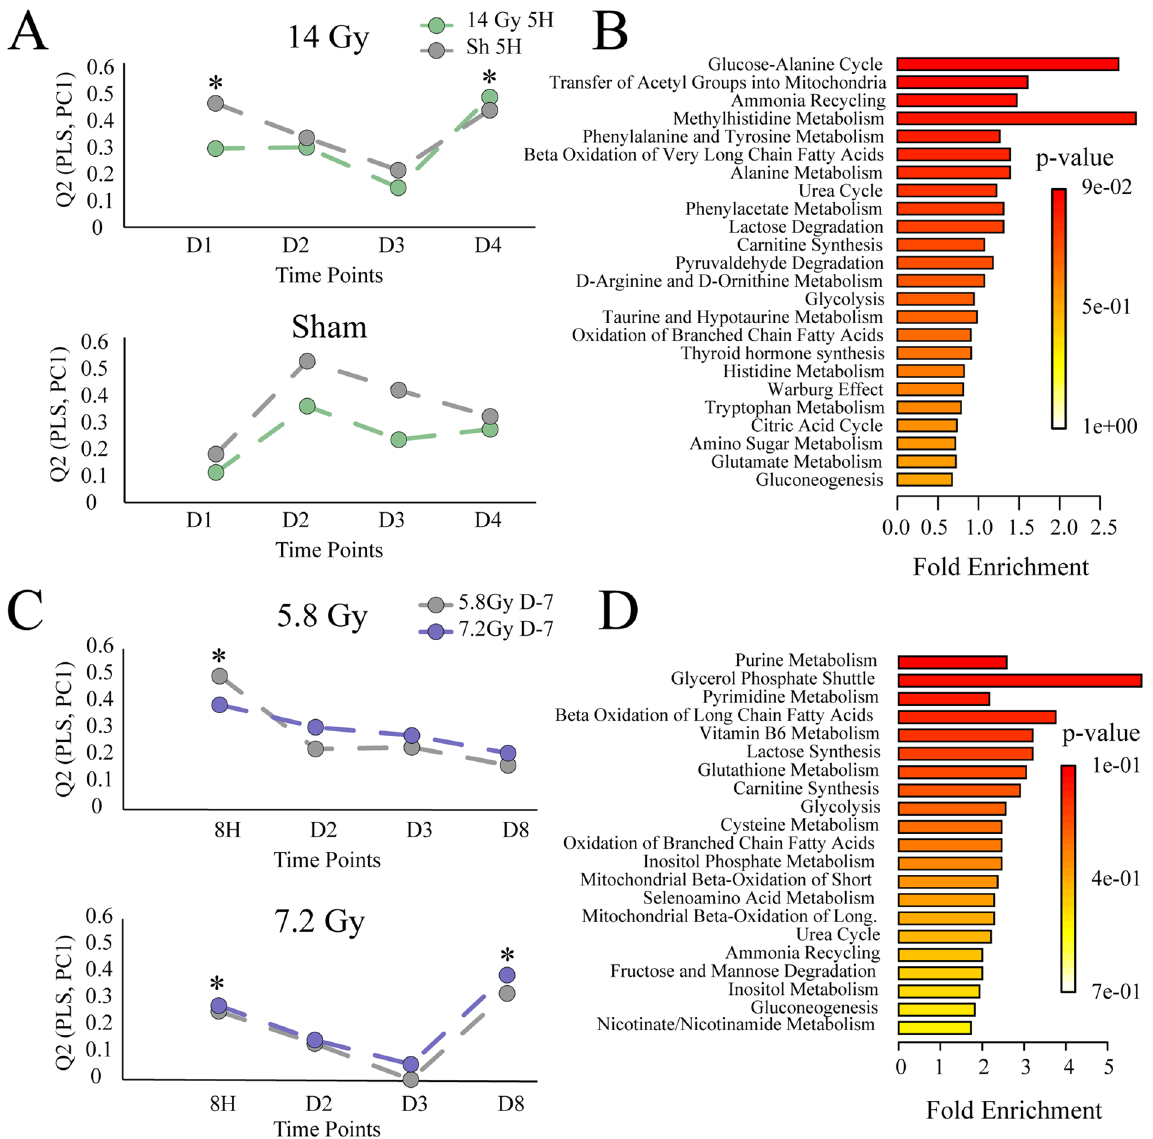
Figure 2. Combined metabolomic analysis following 60 Co γ-radiation exposure. ( A ) Cohort 1 (mice) NMR metabolic trajectories of radiation (top) and Sham (bottom) calculated by PLS from baseline (5H) and visualized across time ( Q 2 ). *Indicates model p-values < 0.05. ( B ) Cohort 1 (mice) MetaboAnalyst pathway enrichment with pathways displayed by fold enrichment. ( C ) Cohort 2 (NHP) metabolic trajectories show 5.8 Gy radiation (top) and 7.2 Gy radiation (bottom) calculated by PLS from baseline (5H) and visualized across time ( Q 2 ). *Indicates model p-values < 0.05 ( D ) Cohort 2 (NHP) MetaboAnalyst pathway enrichment analysis with pathways displayed by fold